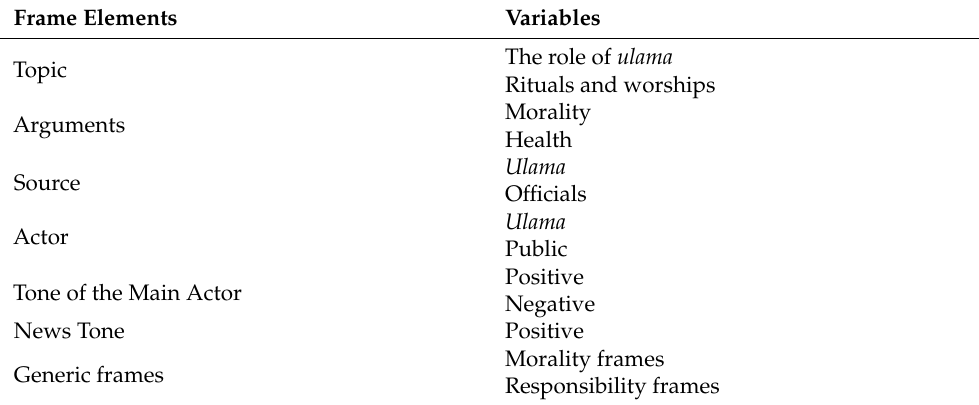
Table 5. The Islamic morality